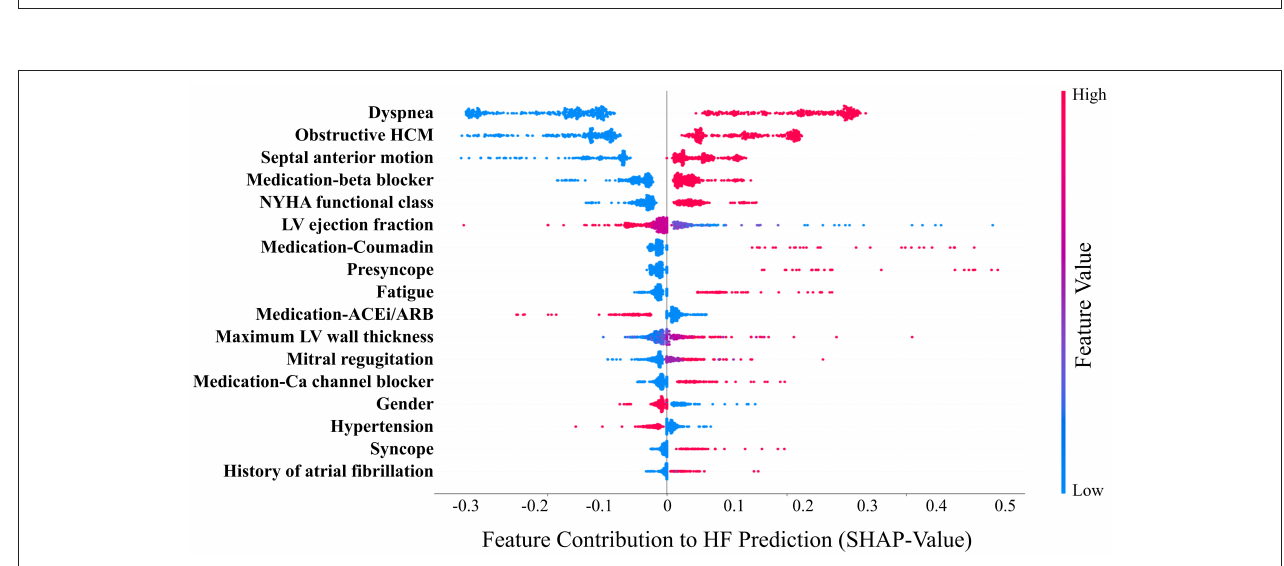
FIGURE 4 | Relative contribution (SHAP-values) of the model variables ( n = 17) to heart failure (HF) prediction. Each point in the graph indicates the contribution of the corresponding clinical variable to the HF prediction of one patient. Ca, calcium; ACEi, angiotensin-converting enzyme inhibitor; ARB, angiotensin-receptor blockers. HCM, hypertrophic cardiomyopathy; LV, left ventricle; NYHA, New York Heart Association.